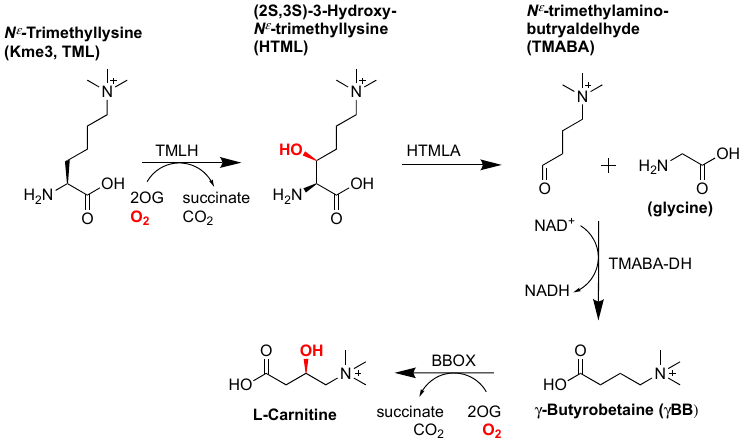
Figure 2. The carnitine biosynthesis pathway starting from trimethyllysine (Kme3).